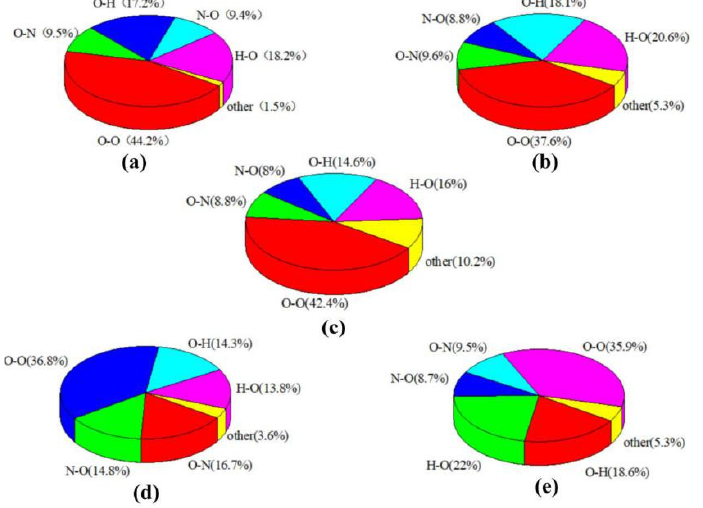
Figure 6. The individual atomic contact percentage contribution to the Hirshfeld surface of CL-20 and its complexes: ( a ) CL-20, ( b ) CL-20/H 2 O 2 , ( c ) CL-20/CO 2 , ( d ) CL-20/N 2 O, and ( e ) CL-20/H 2 O. Table 1. The electrostatic interaction energy (kJ · mol − 1 ) between the two fragments of four host–guest